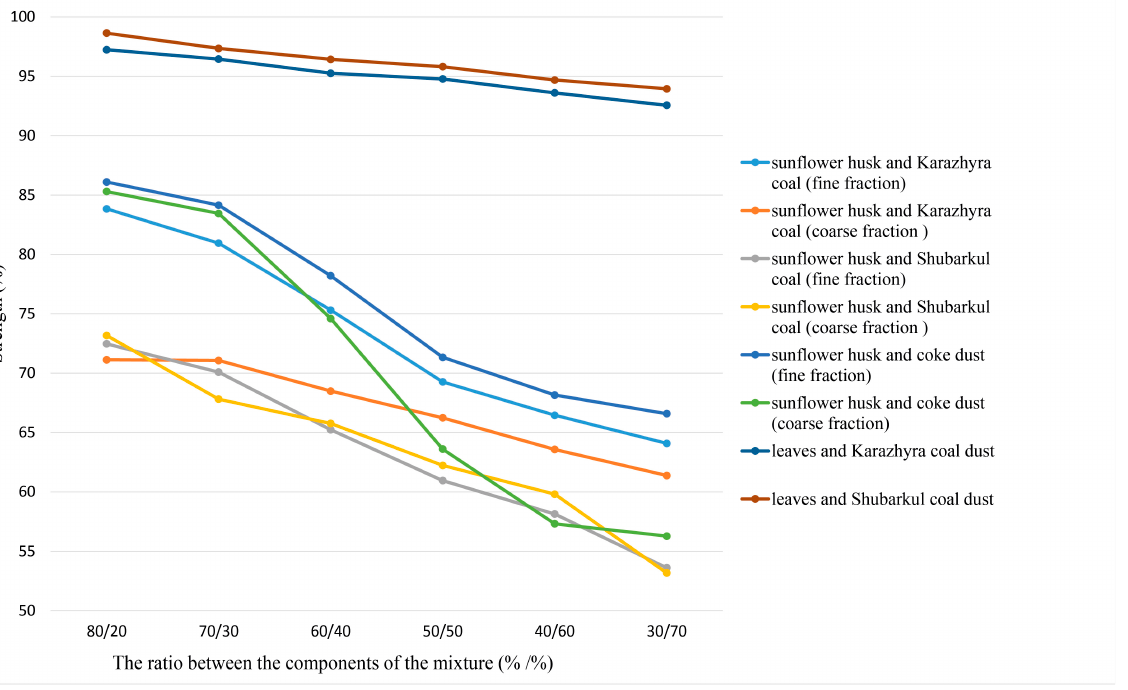
Figure 1. The dependence of the strength of the briquette on the ratio between the components of the